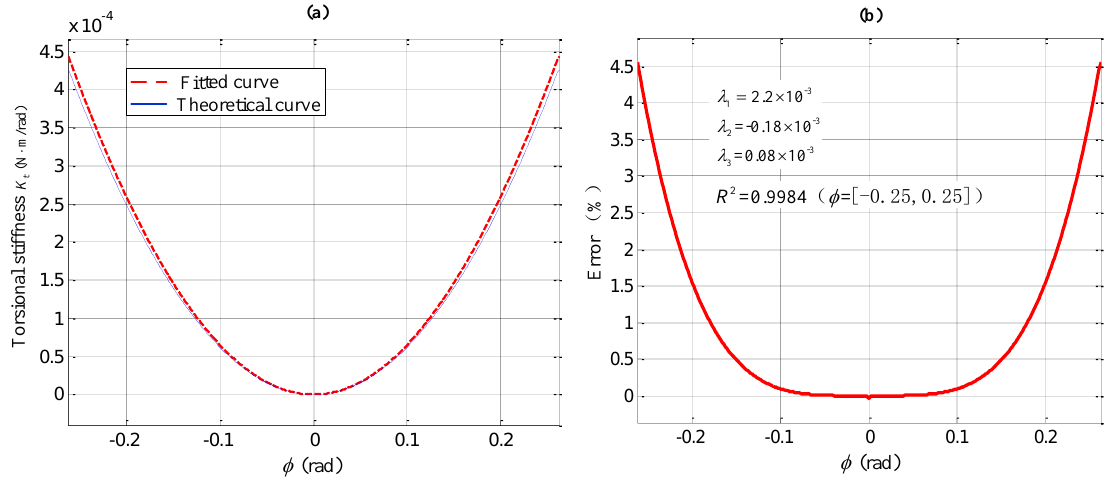
Figure 4. ( a ) Equivalent stiffness and error curves; ( b ) Error distribution.